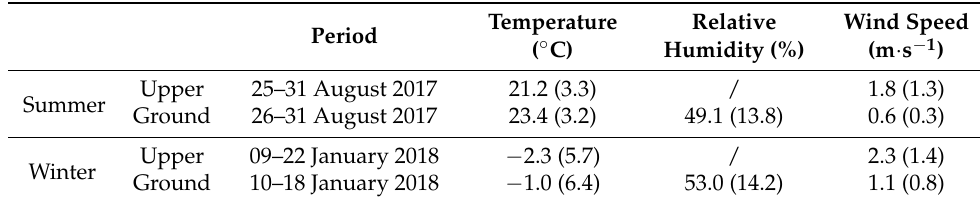
Table 2. Characteristics of the meteorology during the monitoring period (standard deviations are given in parentheses). Temperature Relative Wind Speed Period ( ◦ C) Humidity (%) (m · s − 1 ) Upper 25–31 August 2017 Summer